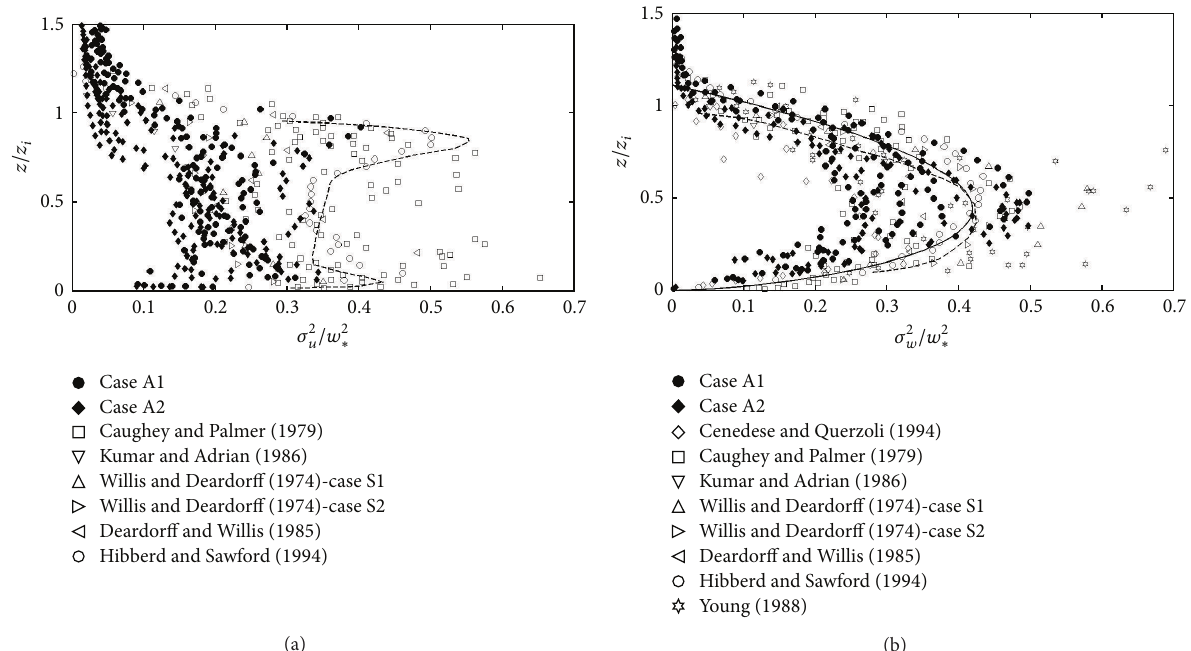
Figure 17: (a) Horizontal and (b) vertical velocity component variance profiles normalized by the Deardorff mixed layer similarity [38] compared with tank experiments and field measurements. The dashed line indicates Adrian et al. [53] results, the full line relation (5).